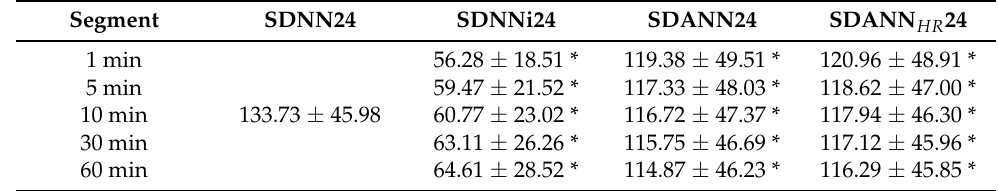
Table 2. Descriptive and statistics analysis of SDNN24 estimations. All the values are expressed in milliseconds (ms).